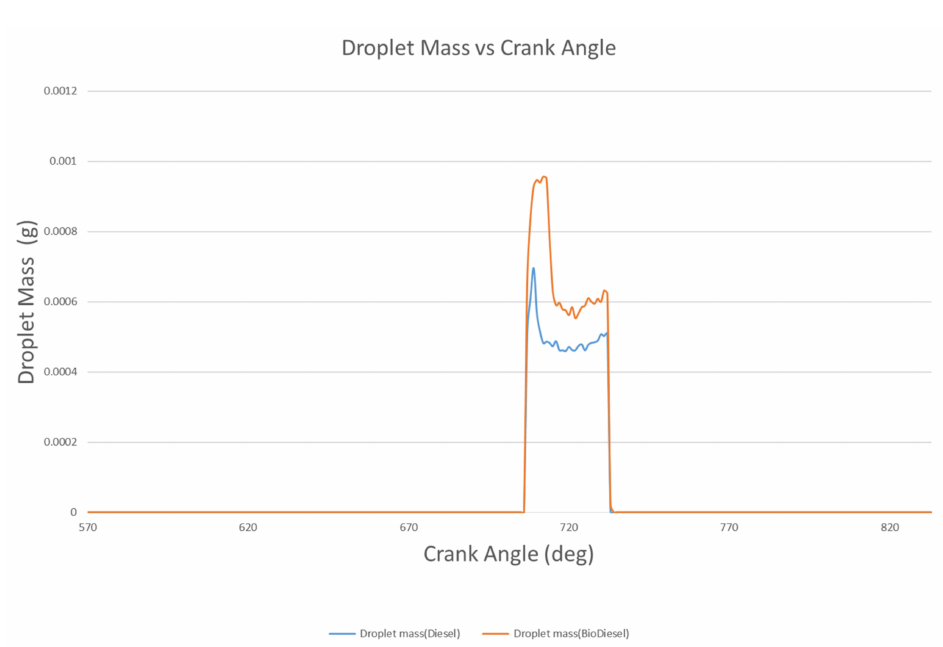
Figure 9. Droplet mass vs. crank